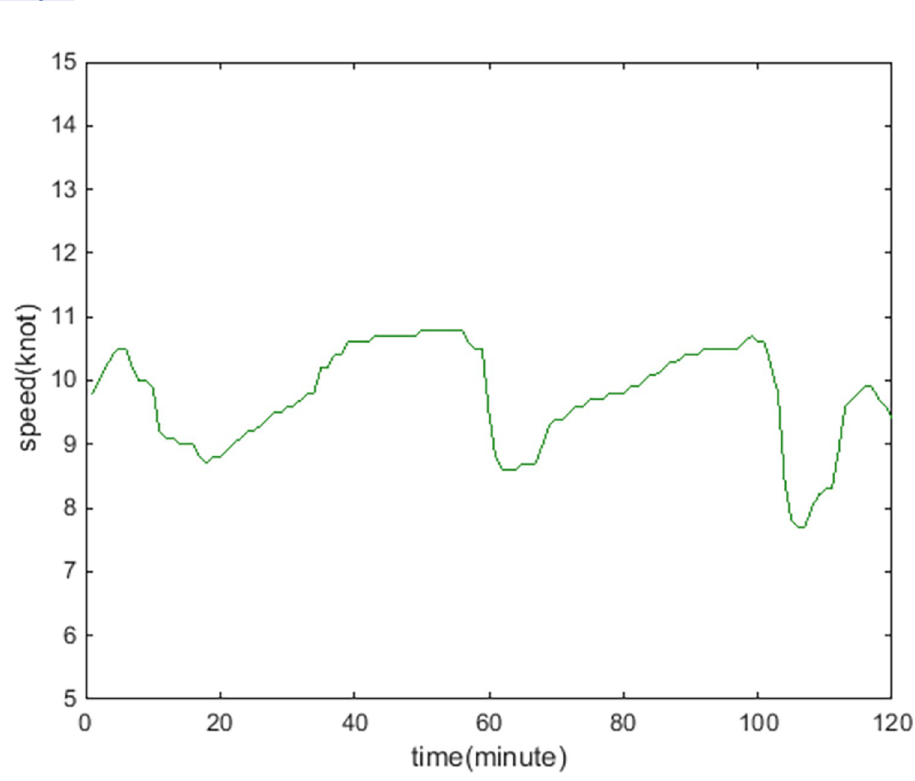
Fig 14. Speed dynamic curve of the own